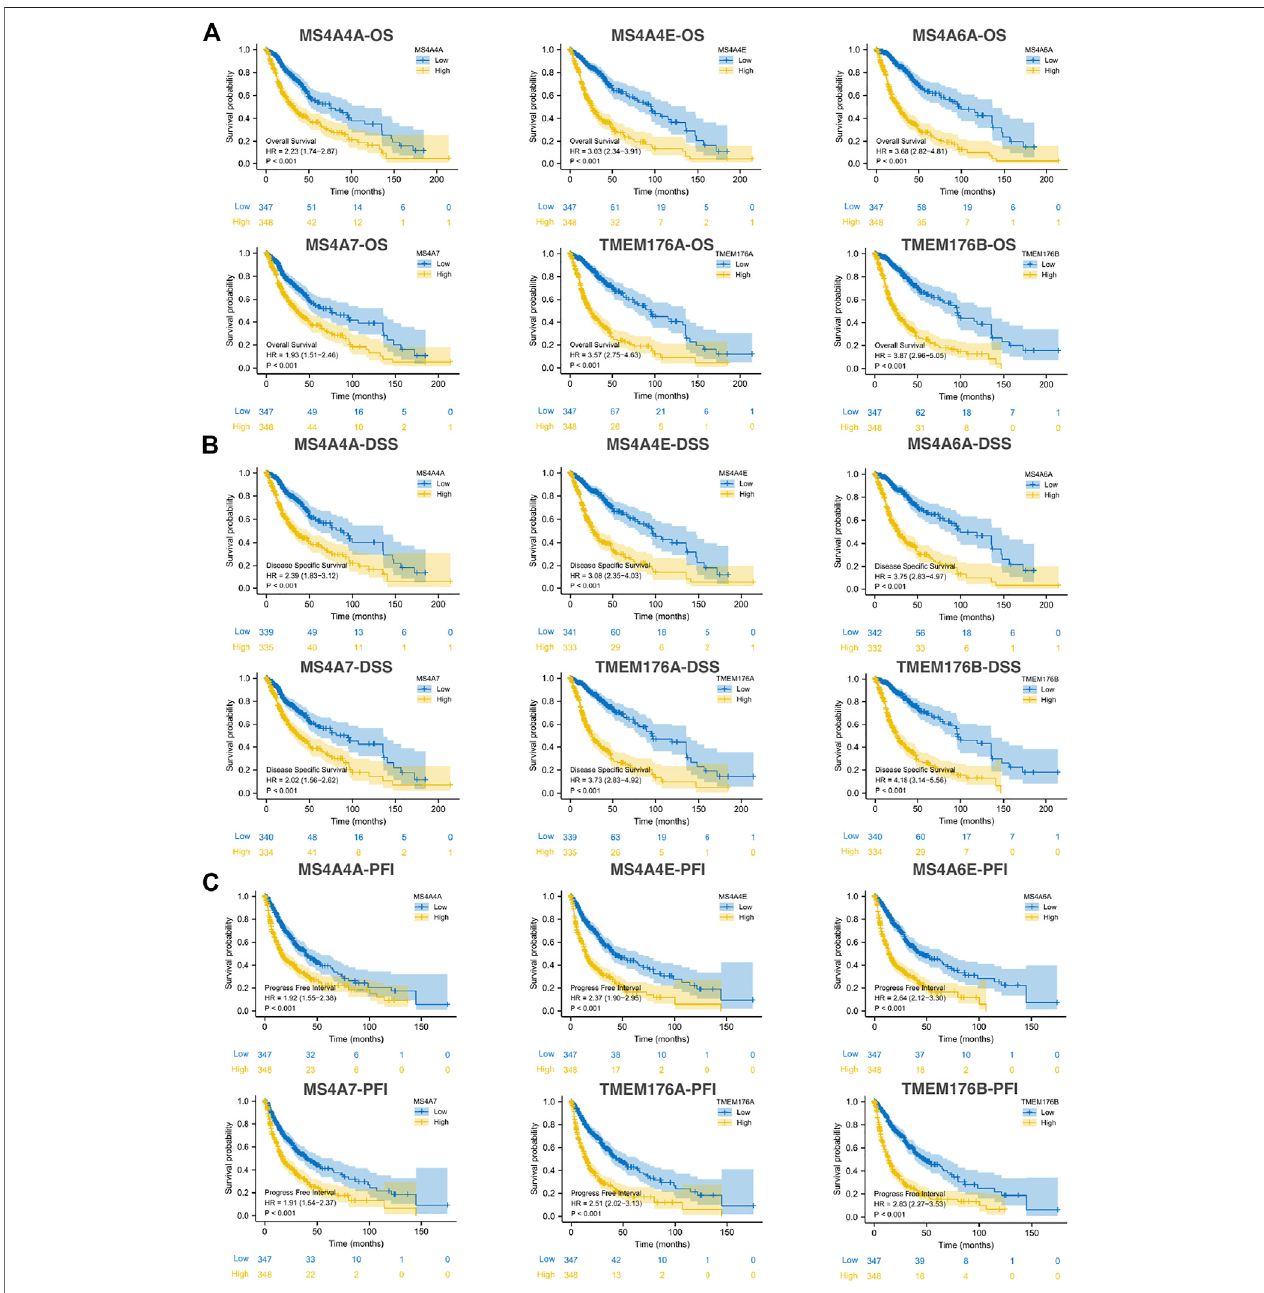
FIGURE 3 | Survival curve for MS4As using data obtained from TCGA [ (A) OS; (B) DSS; and (C) PFI].